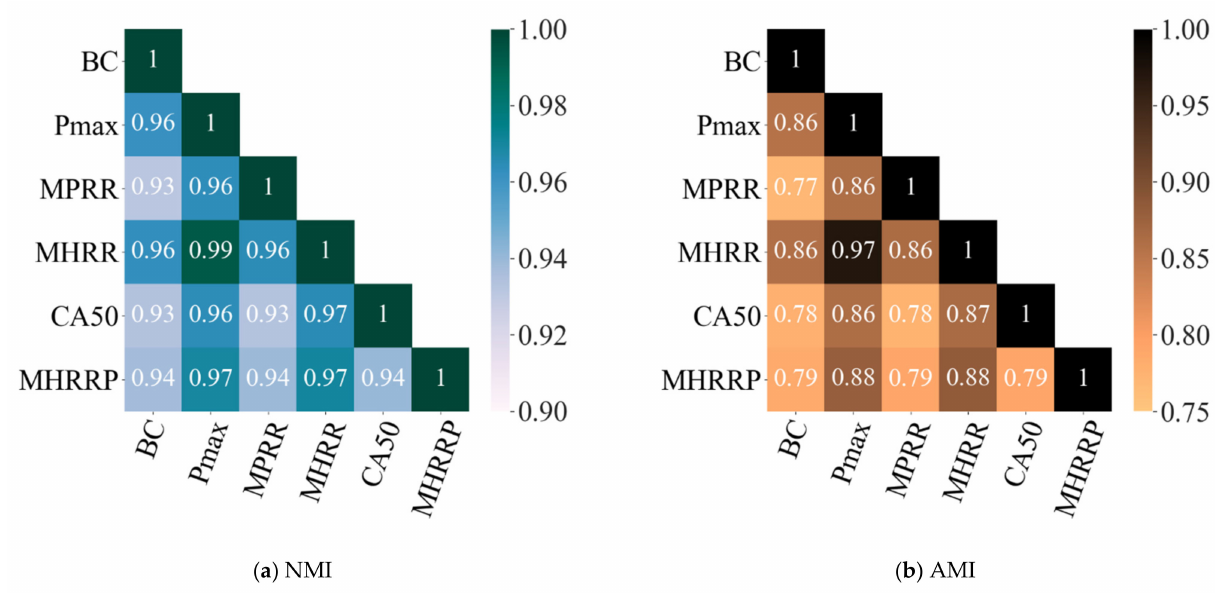
Figure 11. MI heat map of parameters.